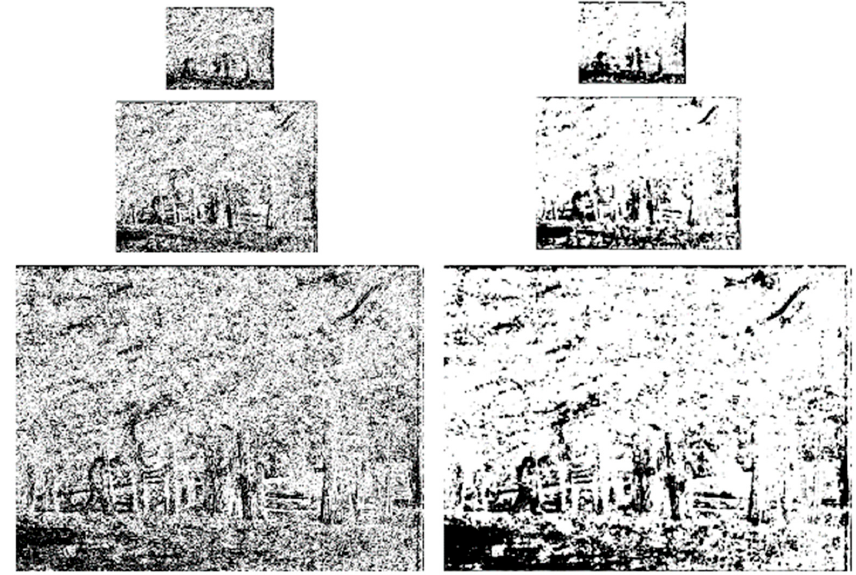
Figure 9. Pyramid fusion selection maps of the static Laplacian fusion (left) and proposed fusion method (right).